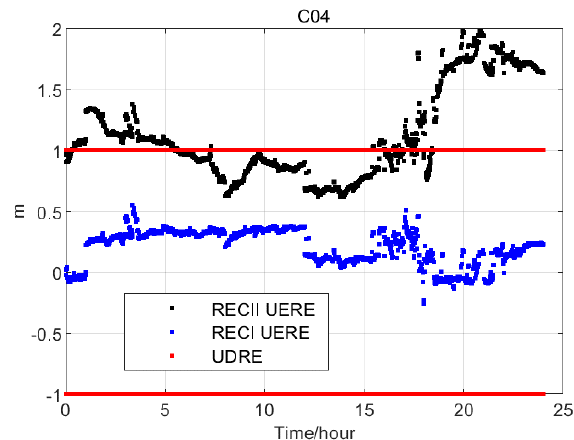
Figure 6. The UEREs of BDS satellites, as calculated by type A and type B receivers under the OS and the WADS.